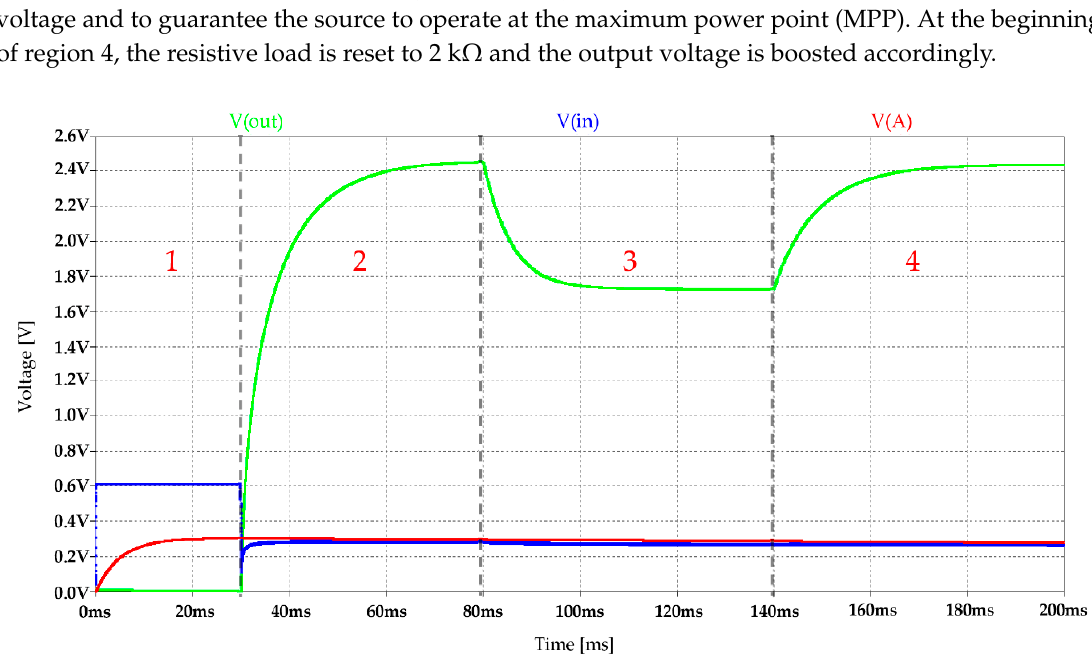
Figure 12. DC/DC converter V OUT (green trace), V IN (blue trace), and V A (red trace) simulation with load step variation. Region 1: input voltage sensing; Region 2: output voltage regulation; Region 3: load changing from 2 k Ω to 1 k Ω and output lowering for MPPT; Region 4: load changing from 1 k Ω to 2 k Ω and output boosting for MPPT.